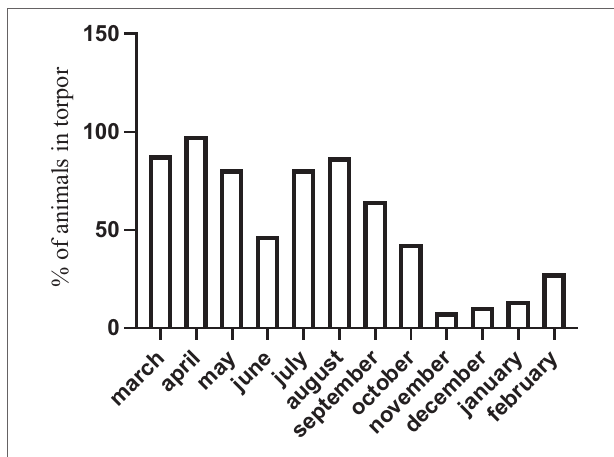
FIGURE 4 | Percentage of torpid D. gliroides (n = 25) in a field study using outdoor enclosures. Torpor incidence was recorded weekly.